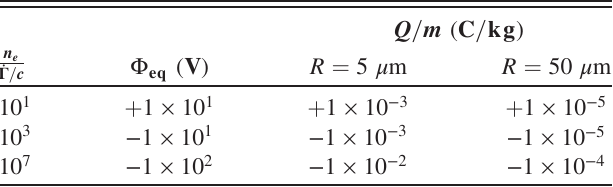
TABLE II. Equilibrium potential and charge-mass-ratio for ¼ 10 eV. Cu grains with radii of T three density ratios and k B e 5 – 50 μ m are considered. The last two rows correspond to the density ratios expected in the